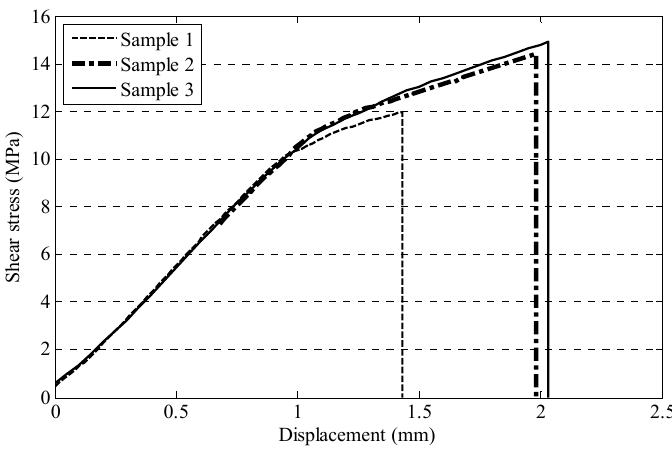
Figure 10. Measured stress from the lap shear test.